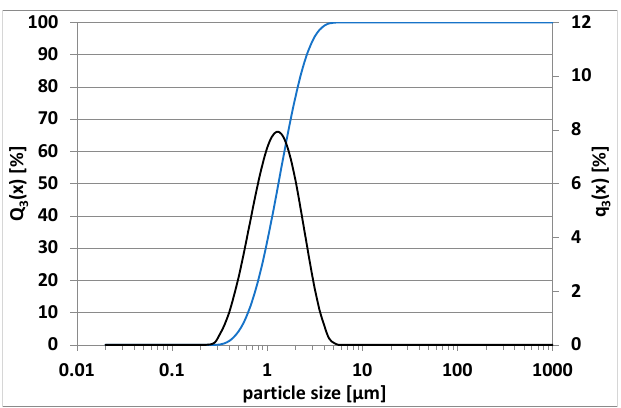
Figure 1. PSD of the AlN powder “TOYALNITE ® -JCGA-BLY5”; cumulative Q 3 (x) and density q 3 (x). The result of the powder analysis shows a monomodal PSD with an average particle diameter of d 50 = 1.31 µm and largest particle diameter of d 100 = 4 µm. In terms of particle size, the AlN powder is thus within the required range for use in the described DLP-based CerAM VPP process and within a component layer thickness of 25 µm. The measurement of the BET surface resulted in a value of 3.66 m 2 /g, not too high and in expectation of a rather low viscosity, which should be well adjustable using the right dispersants as well as surface additives. Decisive for the quality of a shaped component are two essential properties of the used photosensitive suspension—on one hand, the flow behavior, preferably determined by the shear rate-dependent viscosity, and on the other hand, the light-induced polymerization of the suspension dependent upon its formulation as well as the applied exposure energy. Both parameters were investigated using various methods (results presented in Sections 3.2 and 3.3) to derive a suitable CerAM VPP setting, which means process speeds (e.g., vat rotation) and the required exposure energy dose for layer- building. 3.2. Viscosity and Flow Behavior of Developed AlN Suspensions As described in Section 2.4, the CerAM VPP process based on the Lithoz LCM technology works using a light-transparent vat filled with a photosensitive ceramic suspension, which is coated using a doctor blade to a thin layer of 100 to 400 µm. A schematic representation of the suspension coating and vat rotation situation within the process has been previously described [35]. For instance, using an average coating thickness of approx. 200 µm at a vat rotation speed of 150°/s is associated with shear rates up to 1000 1/s. Due to that fact, the used photocurable suspension should have a viscosity that varies only slightly in this shear rate range, preferably within 2 powers of 10, to ensure a good layer coating. The viscosity of a suspension for this process should be not too low or too high. In the case of a viscosity that is too low, wettability problems will arise leading to pores within the green and sintered component; a viscosity that is too high will result in low flowability, and the coating of thin suspension layers cannot be guaranteed. Crucial for high-quality components is a homogeneous thin layer achievable through an ideal suspension viscosity. This requires good control of suspension viscosity, especially having a shear thinning behavior at low shear rates (1–10 1/s) [43,44]. The developed AlN suspensions of this study are based on a low viscous tetrafunctional polyether acrylate and an aliphatic urethane di-acrylate mixed in a weight ratio of 7:3 and modified using a non-reactive plasticizing fluid. Therefore, only the dispersant and its contents were used to control the viscosity and stability of the developed AlN suspension.